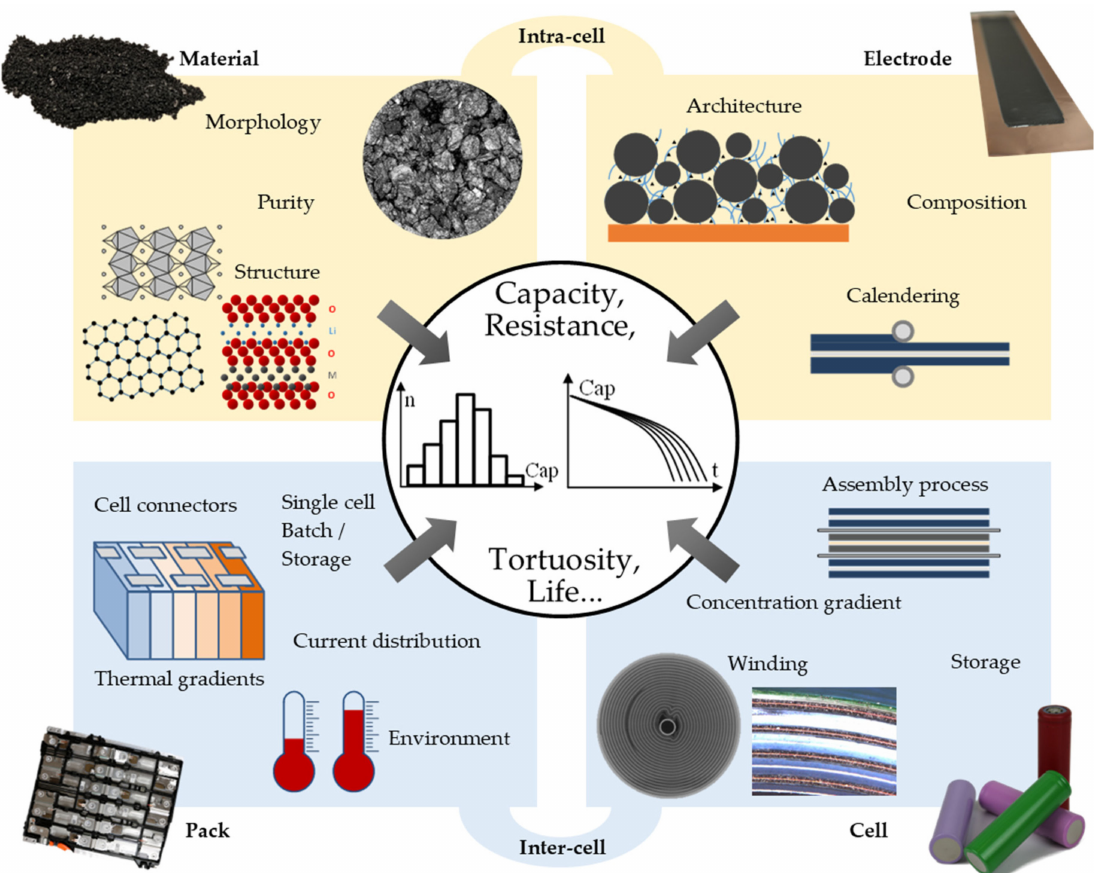
Figure 1. Multiscale breakdown of the origins of intra (yellow) and inter-cell (blue)